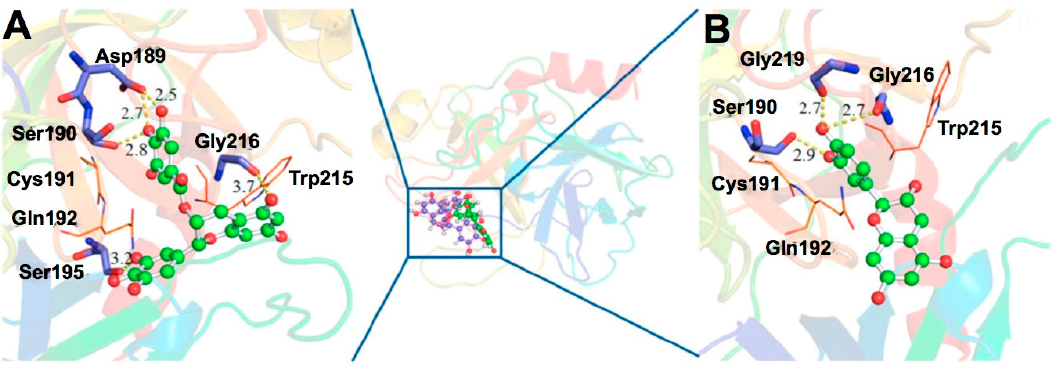
Figure 3. CMDA of complexes of trypsin and catechins. Representative complex structures for trypsine complex with EGCG ( A ) and catechin ( B ). EGCG and catechin are shown as ball-and-stick and trypsine as cartoon. Data are cited from a literature of Shi et al. [14]. Adapted with permission of Copyright (2017) American Chemical Society.